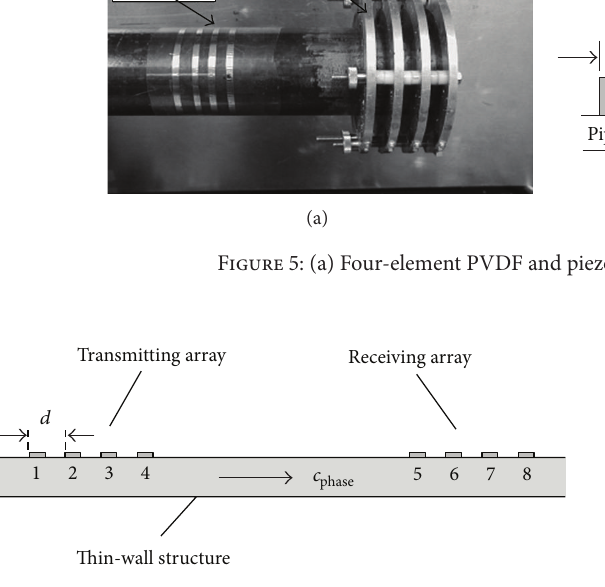
Figure 6: Phased arrays for tuned wave generation and